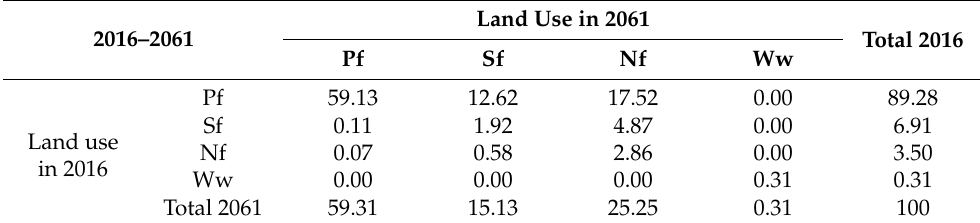
Table 9. Transition matrix in the REC scenario between 2016 and